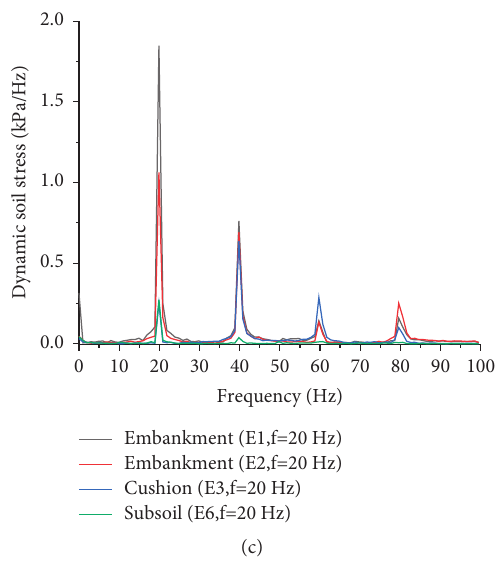
Figure 15: Frequency spectral analysis of dynamic soil stress at embankment, cushion, and subsoil for three cyclic loading frequencies. (a) f � 5 Hz. (b) f � 10Hz. (c) f � 20Hz.